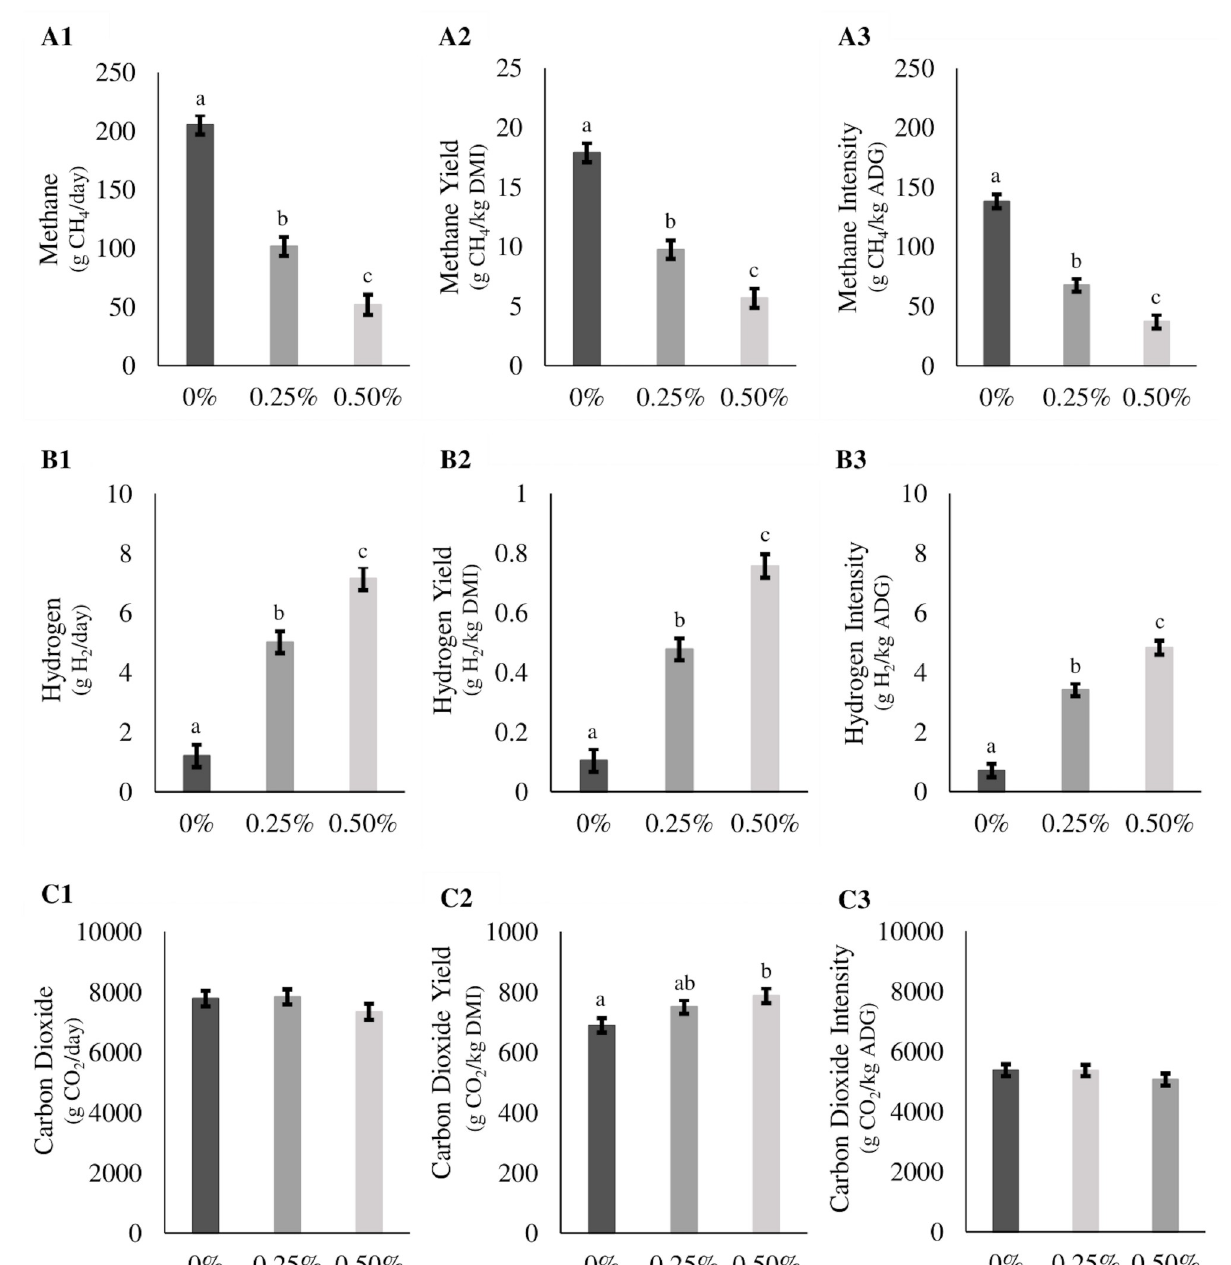
Fig 2. Asparagopsis taxiformis inclusion effects on methane, hydrogen and carbon dioxide emissions over a 147-day period. Means, standard deviations, and statistical differences of methane, hydrogen, and carbon dioxide production (g/d) (A1,B1,C1), yield (g/kg dry matter intake (DMI)) (A2, B2,C2), and intensity (g/kg average daily gain) (A3,B3,C3) for 0%, 0.25% (Low), and 0.50% (High) Asparagopsis taxiformis inclusion. Means within a graph with different alphabets differ ( P < 0.05). was reduced by 51.8 and 86.8%, 44.6 and 79.7%, and 54.4% and 82.4%% for the Low and High treatments, respectively. Furthermore, H production, yield and intensity significantly 2 increased by 326 and 535%, 404 and 753%, and 341 and 626% for the Low and High treat- ments, respectively. Steers fed low forage TMR and supplemented with A . taxiformis reduced